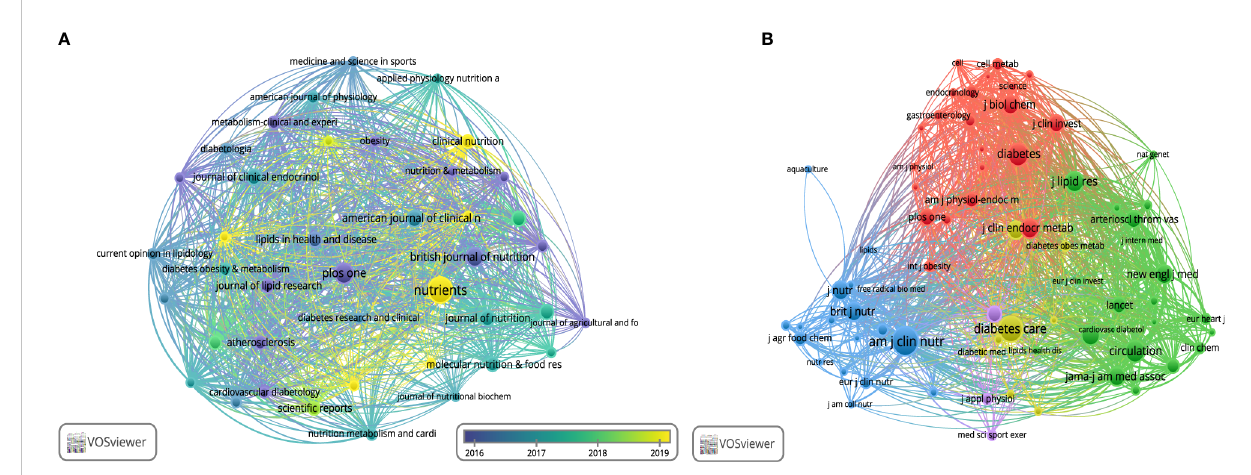
Supplementary Figure S3A. The timeline view of author